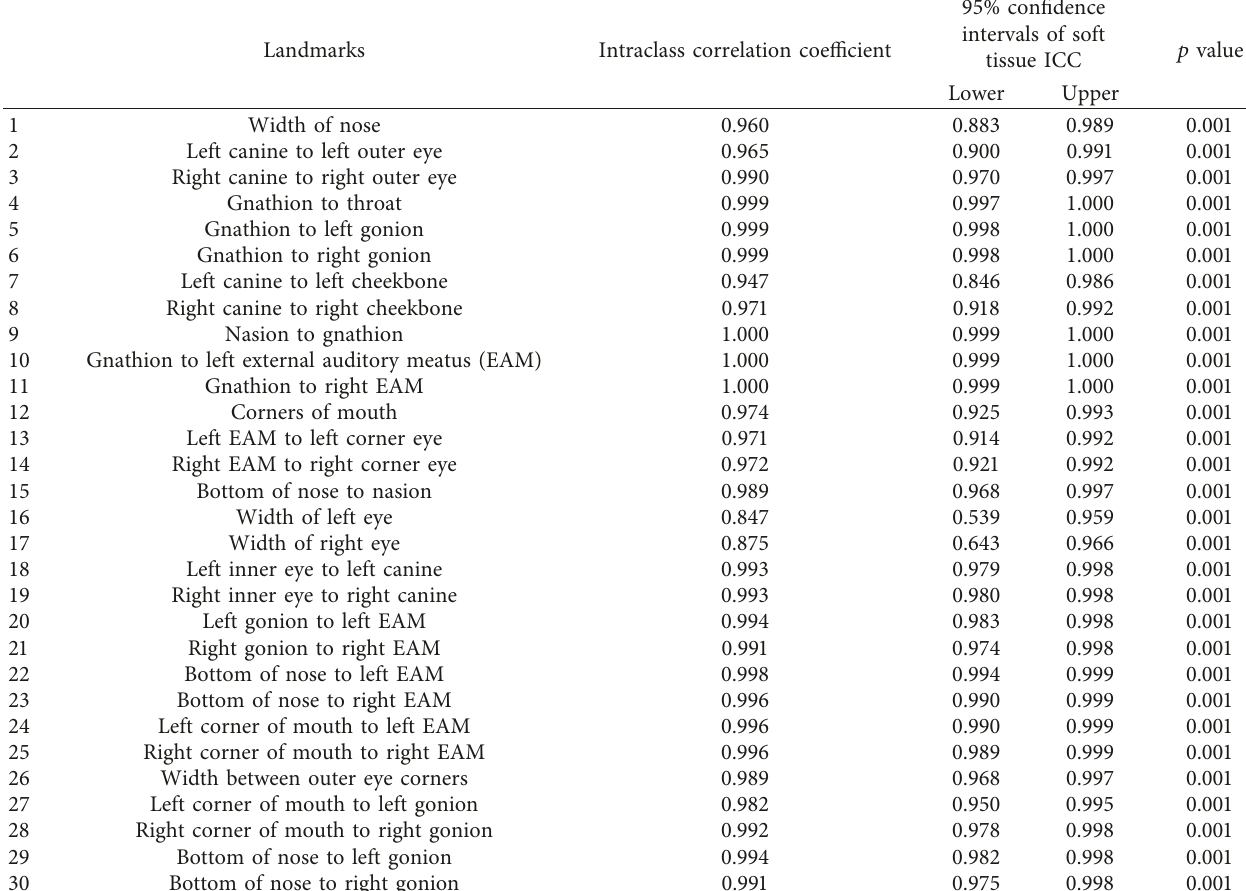
Table 4: Intraclass correlation coefficients (ICC) of facial scan landmarks, lower and upper limits of their 95% confidence intervals, and their corresponding p values.